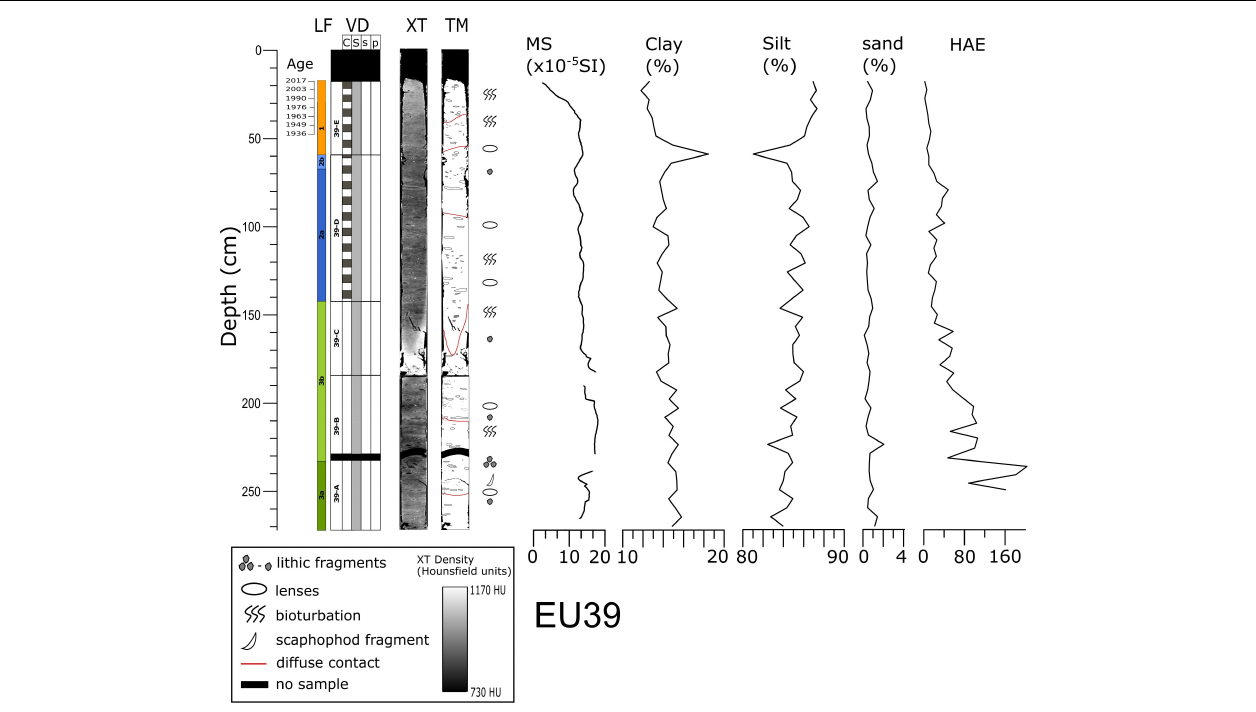
FIGURE 8 | EU39 sediment core with lithofacies identification (LF); Age (from 210 Pb dating); original granulometric visual description (VD), showing Clay (C), Silt (S), sand (s) and pebbles (p) contents; X-Ray tomographic image (XT), and interpreted mapping (TM); magnetic susceptibility (MS); laser granulometry showing clay, silt and sand contents; high attenuation elements from XT